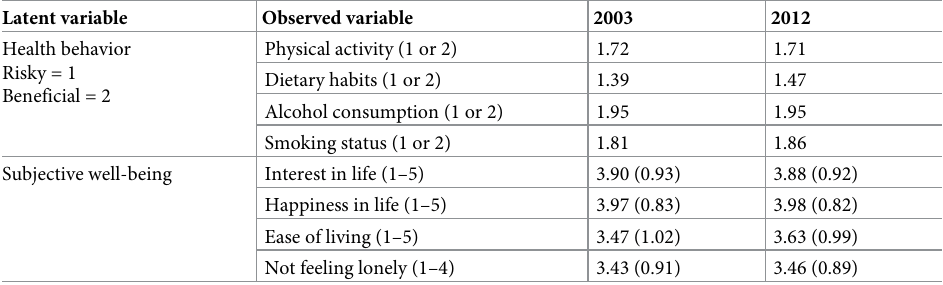
Table 3. Means (standard deviations) of observed variables in the Health and Social Support (HeSSup) study.